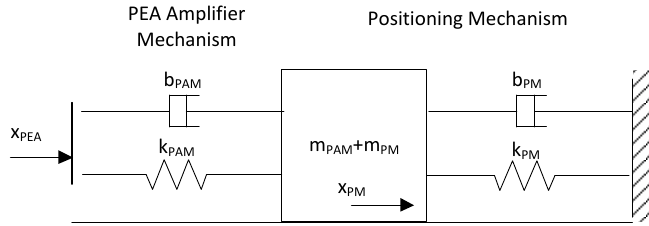
Figure 5. Simplified mechanical model for the positioning system.